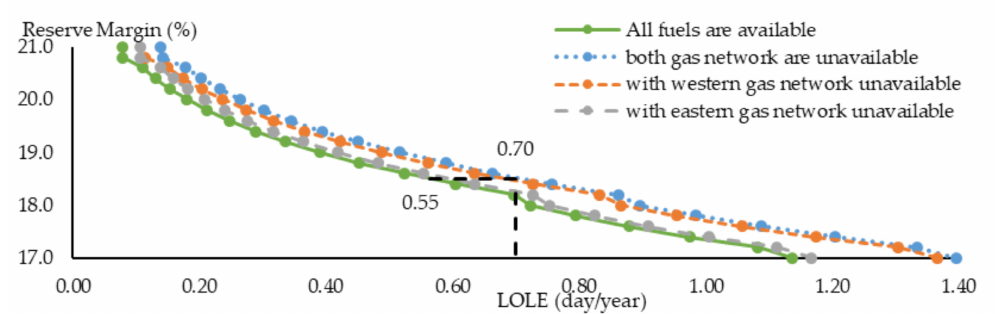
Figure 13. LOLE with natural gas supply